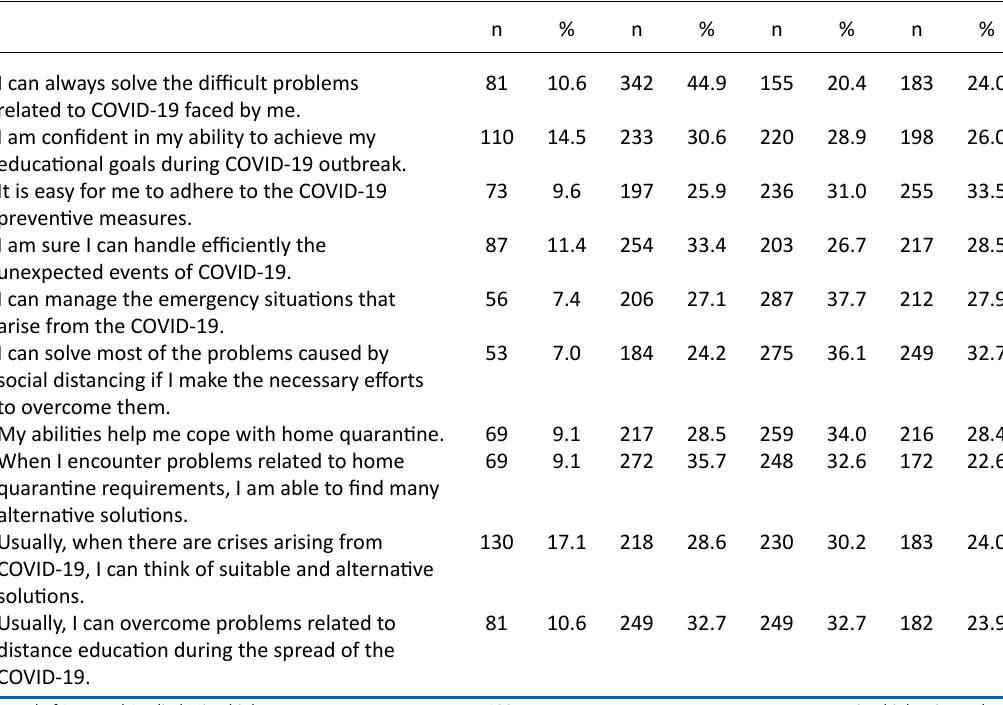
Table 2. Students’ SE during the period of COVID-19 pandemic (n= 761)